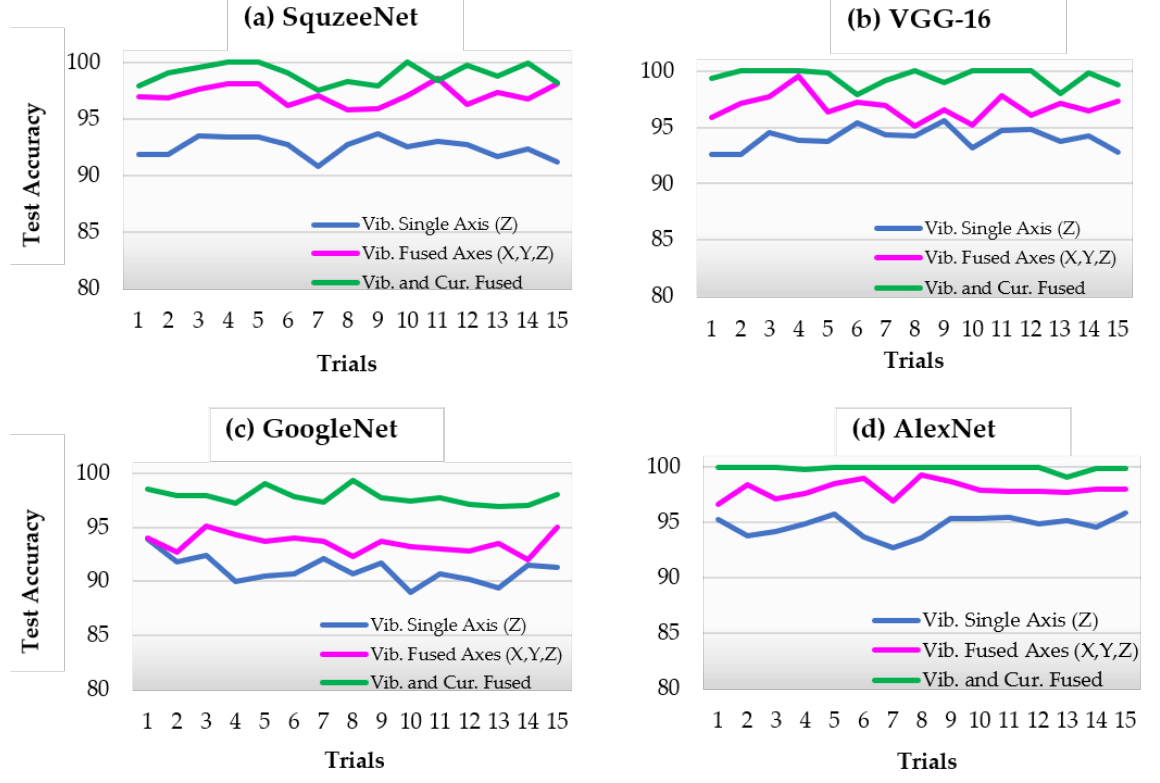
Figure 8. Testing accuracy versus experimental trials performed for each deep neural network model.